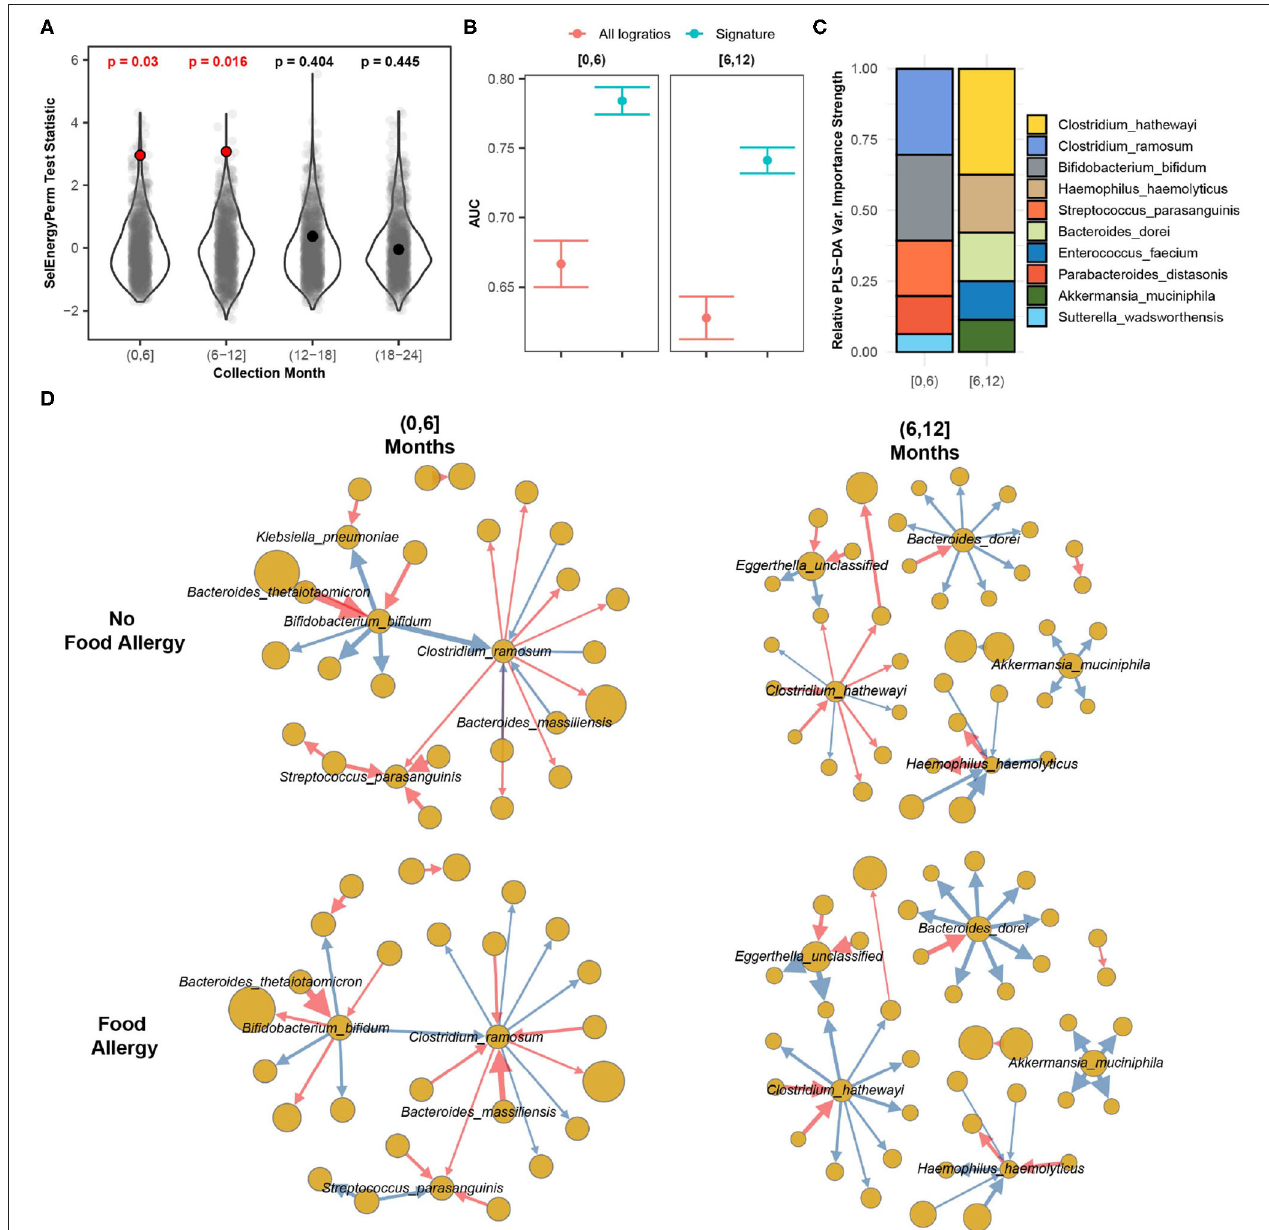
FIGURE 8 | SelEnergyPerm case study examining the association between the gut microbiomes of infants in early life and the development of food allergy later in life. (A) SelEnergyPerm permutation test (permutations 1,000) results displaying the null distribution of the test statistic (violin and gray points) and the empirical test = statistic (red if significant, black otherwise) with Benjamini–Hochberg-corrected p -values. Test statistics values were z -score scaled by collection period to improve visualization. (B) AUC comparisons of future food allergy development discrimination using PLS-DA. Models were trained with repeated ( r 20) 10-fold stratified (host = and food allergy development) cross-validation using either the SelEnergyPerm signature or all logratios. Points represent the mean AUC and error bars indicate the 95% CI. (C) Relative taxa strength by family measuring the importance of each taxon for discriminating between food allergy statuses later in life across each collection month. Relative strength was computed using the top 5 nodes derived from the PLS-DA variable importance weighted logratio networks across each collection month. (D) Directed (edges point out from numerator to denominator) networks of the SelEnergyPerm-derived signature by collection period and food allergy development weighted by the absolute logratio means [nodes taxa, node size mean strength, edge logratio, edge width logratio mean, red edges = = = = = negative logratio mean (incoming node more abundant), blue edges positive logratio mean (outgoing node more =